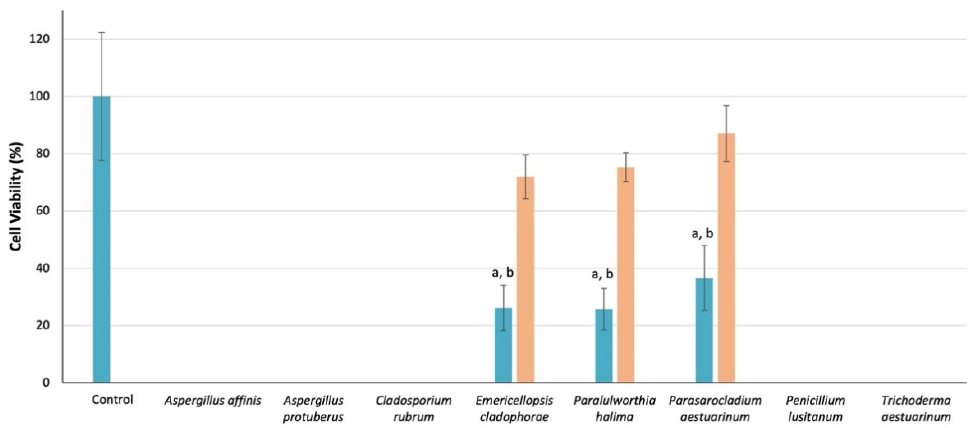
Figure 4. Cytotoxicity of the culture media extracts (250 mg/mL) with (blue) and without 3% sea salt (orange) of E. cladophorae (MUM 19.33), Paral. halima (MUM 20.56) and Paras. aestuarinum (MUM 19.35) using Vero cells. Data are shown as average ( n = 5) ± standard error. (a) indicates a significantly different t -test, p < 0.05, in relation to the correspondent non-saline sample, and (b) indicates a significantly different t -test, p < 0.05, in relation to the control.